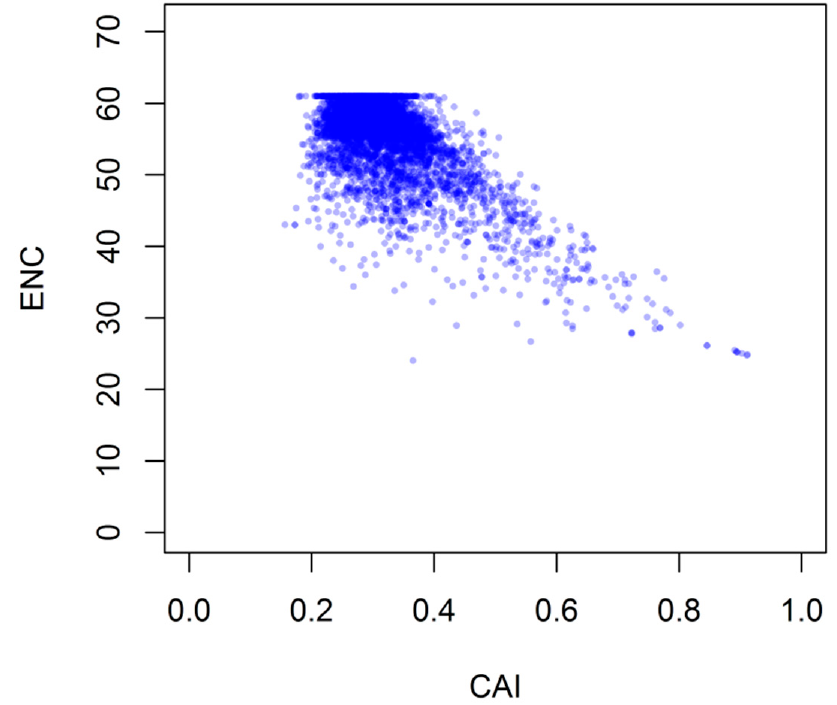
Figure 7. Relationship between ENC and gene expression level for. As shown in Figure 8, correlation analysis between protein size and axis 1 values indicated that the 3 correlation coefficients (r = − 0.0817, 0.1822, − 0.1254, respectively, p < 0.01) all significantly correlated, suggesting that genes with higher expression levels had a smaller